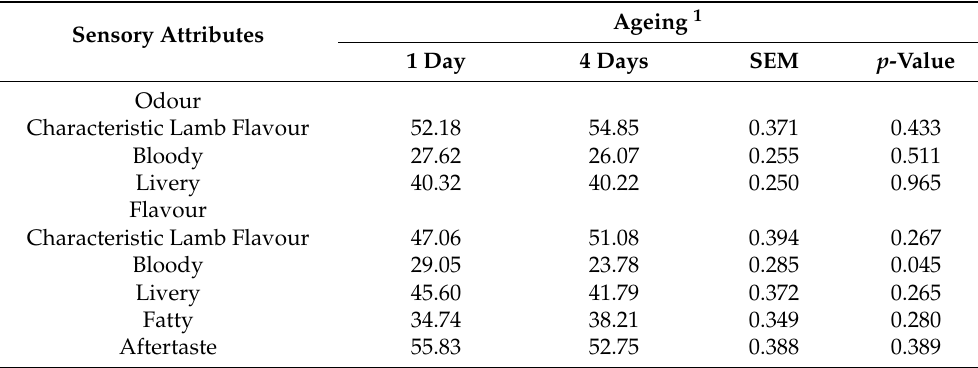
Table 3. Mean scores of sensory odour and flavour attributes of the Longissimus thoracis muscle from Navarra breed lambs aged 1 and 4 days.